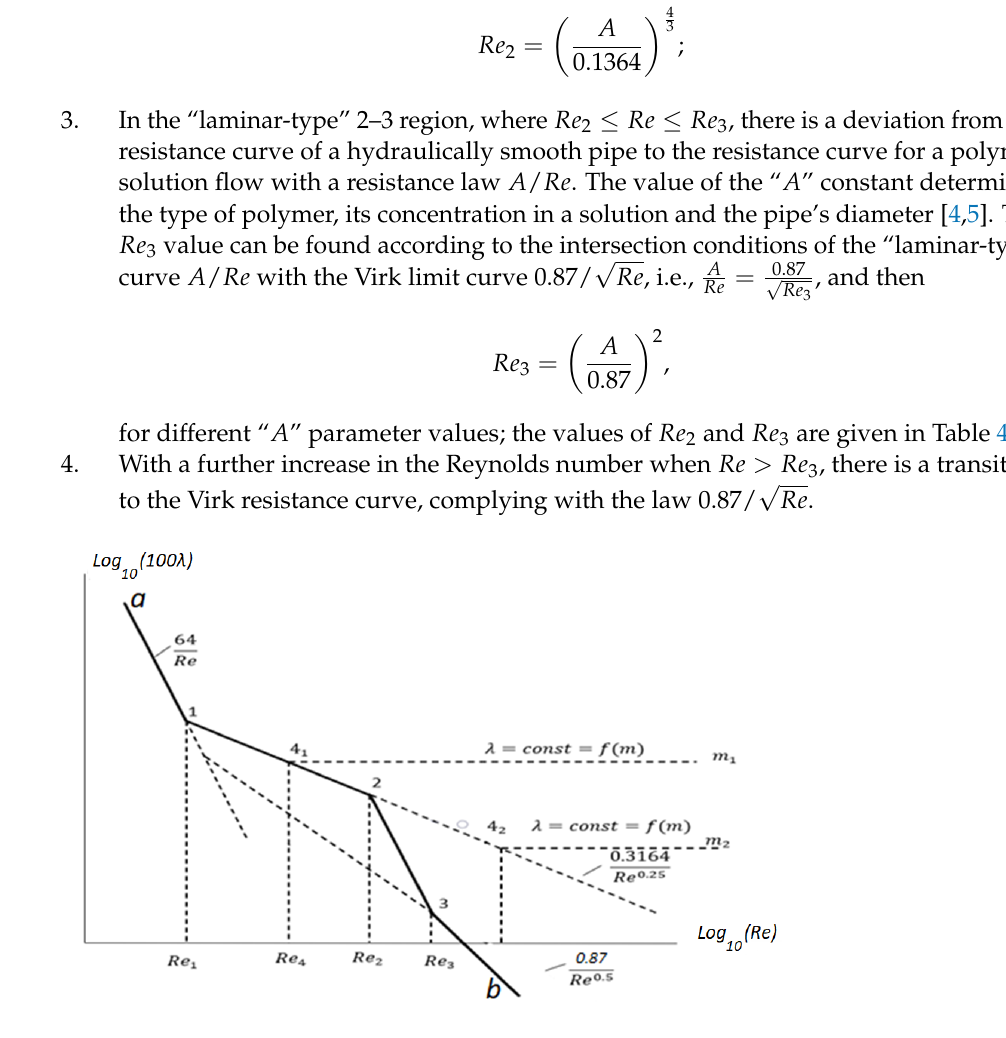
Figure 4. Resistance change scheme for fluid flow in a pipe. Table 4. Values of Re 2 and Re 3 for different A